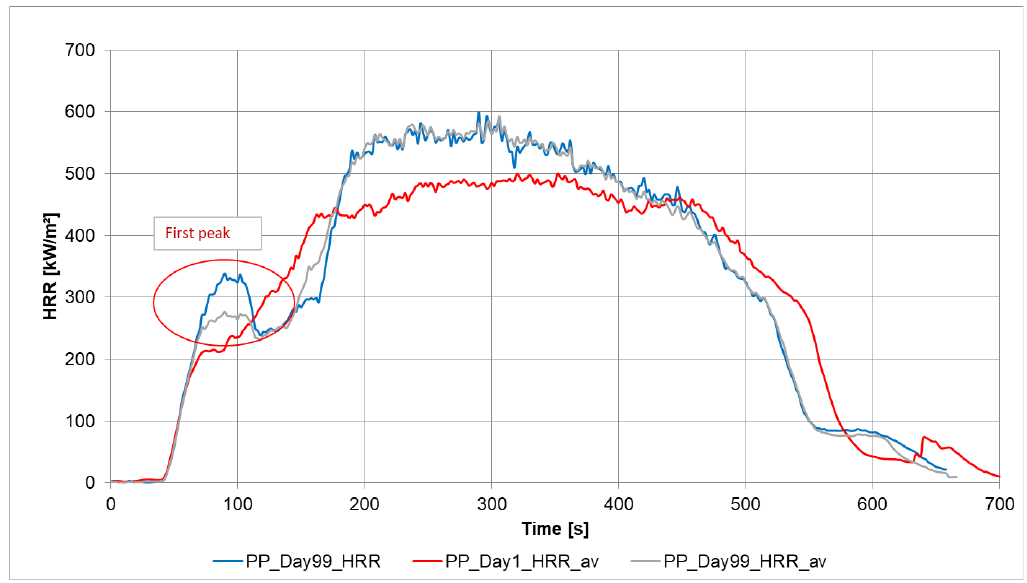
Figure 6. Heat Release rate of pressed granules of PP from the first day (average) and day 99 (one measurement (PP_Day99_HRR) and average of three measurements PP_Day99_HRR_av).